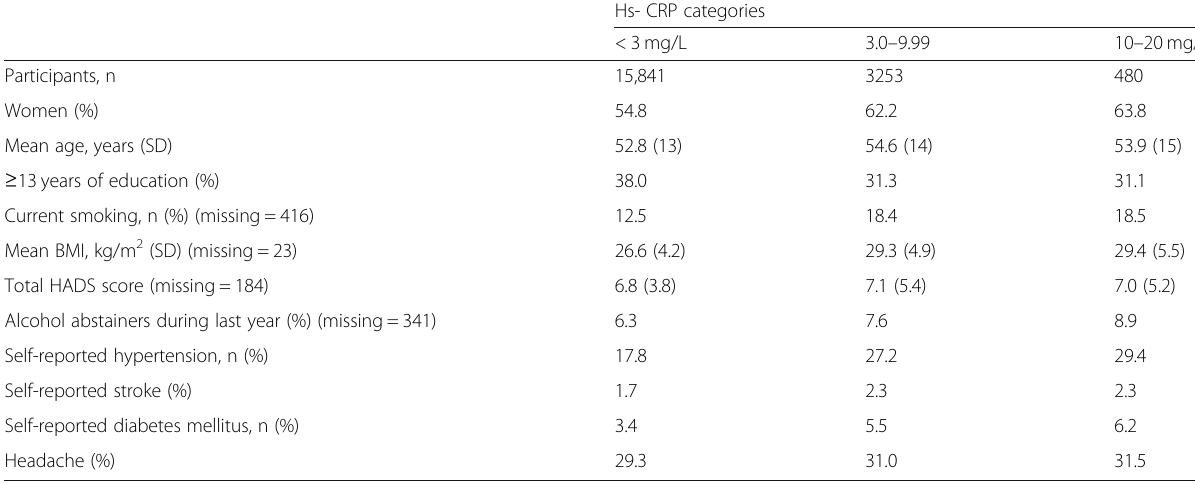
Table 1 Characteristics of participants ( n = 19,574) at baseline in HUNT3 related to categories of high sensitivity C-reactive protein (hs-CRP)